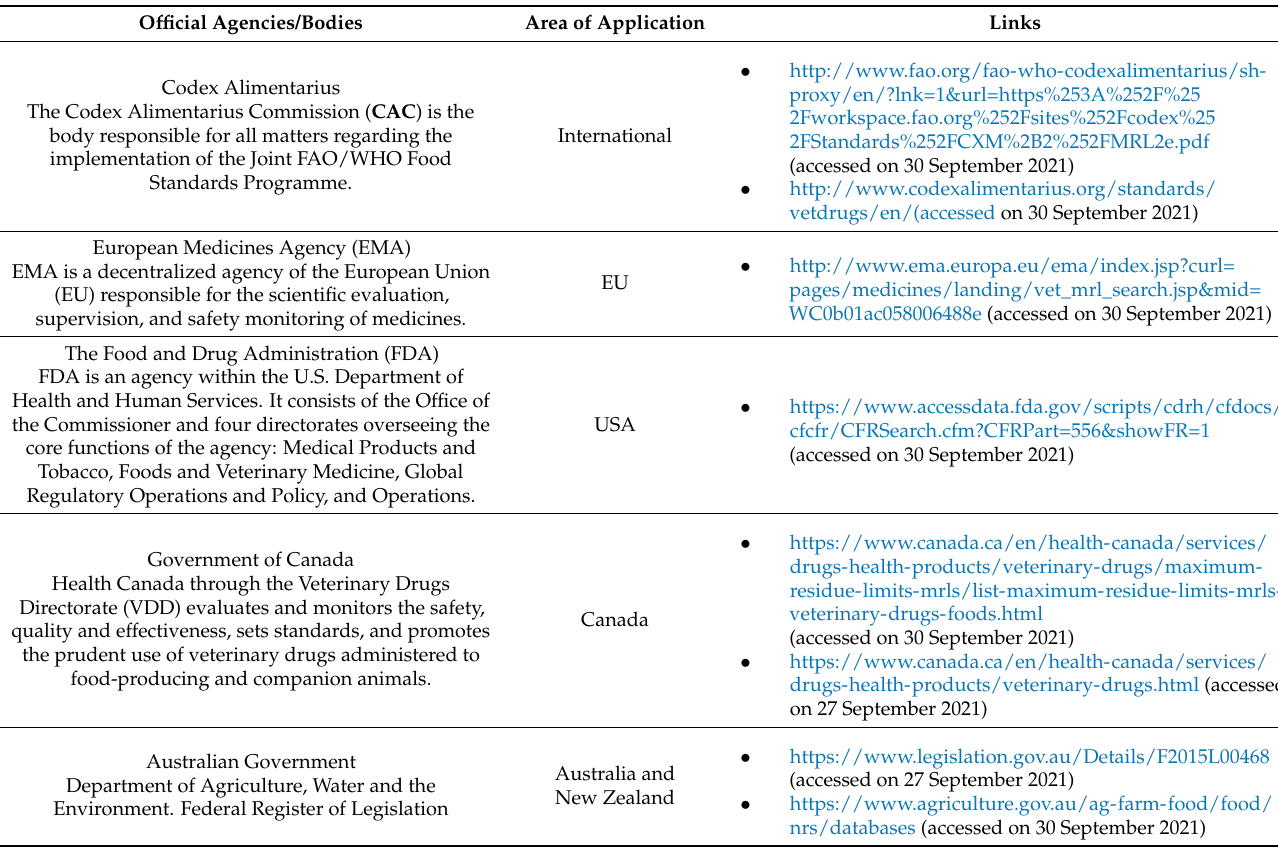
Table 1. Agencies or official bodies that report toxicological evaluations and parameters, such as the no-observed-adverse- effect level (NOAEL), the acceptable daily intake (IDA), the maximum residue limits (MRL), or tolerances established for veterinary